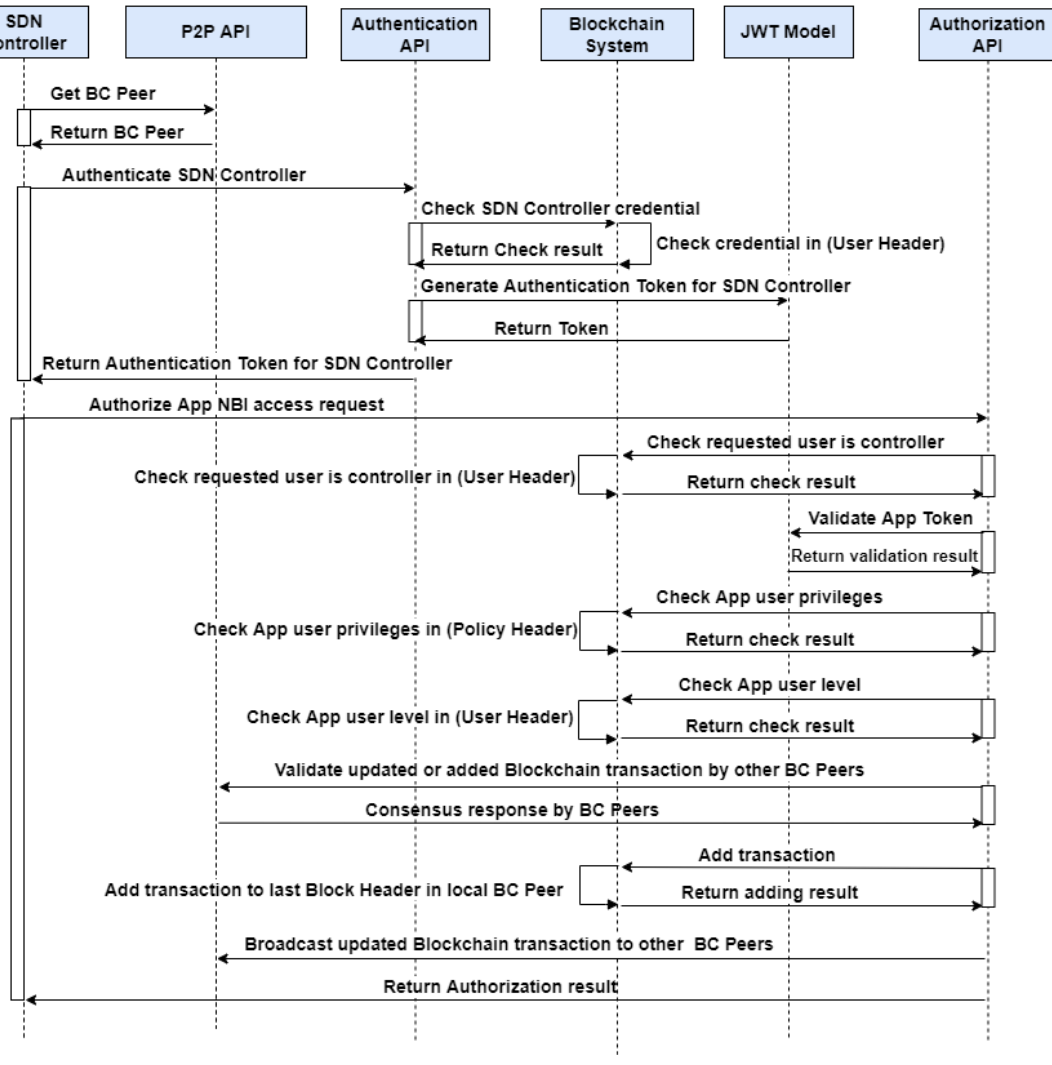
Figure 5. Authorization API